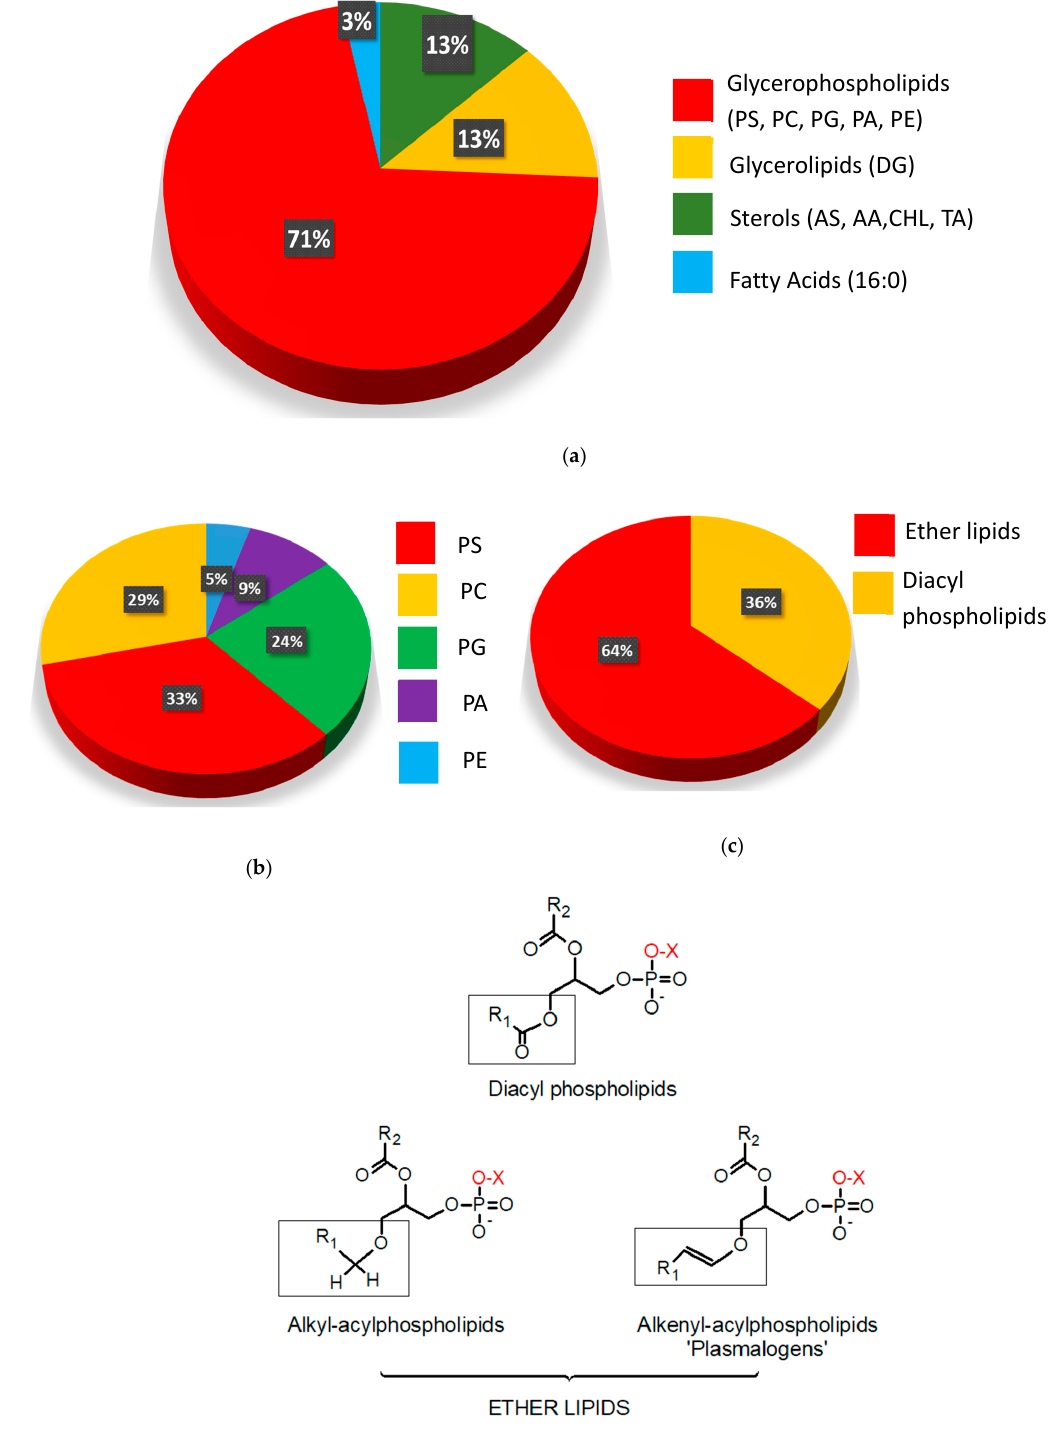
Figure 2. Distribution of the annotated metabolites according to major lipid classes. ( a ) AS = androsterone sulfate, AA = apocholic acid, CHL = cholesterol, TA: trihydroxycoprostanoic acid, DG: diacylglycerols and Fatty acid 16:0 = palmitic acid. ( b ) Distribution in the class of glycerophospholipids (GPL): PS: phosphatidylserine, PC: phosphatidylcholine, PG: phosphatidylglycerol, PA: phosphatidic acid and PE: phosphatidylethanolamine. ( c ) Percentages of ether and diacyl GPL. ( d ) General chemical structures of GPL where X: serine, choline, glycerol, H or ethanolamine. The di ff erent kinds of binding to the fatty acid moiety of the glycerol oxygen in the SN1 position are